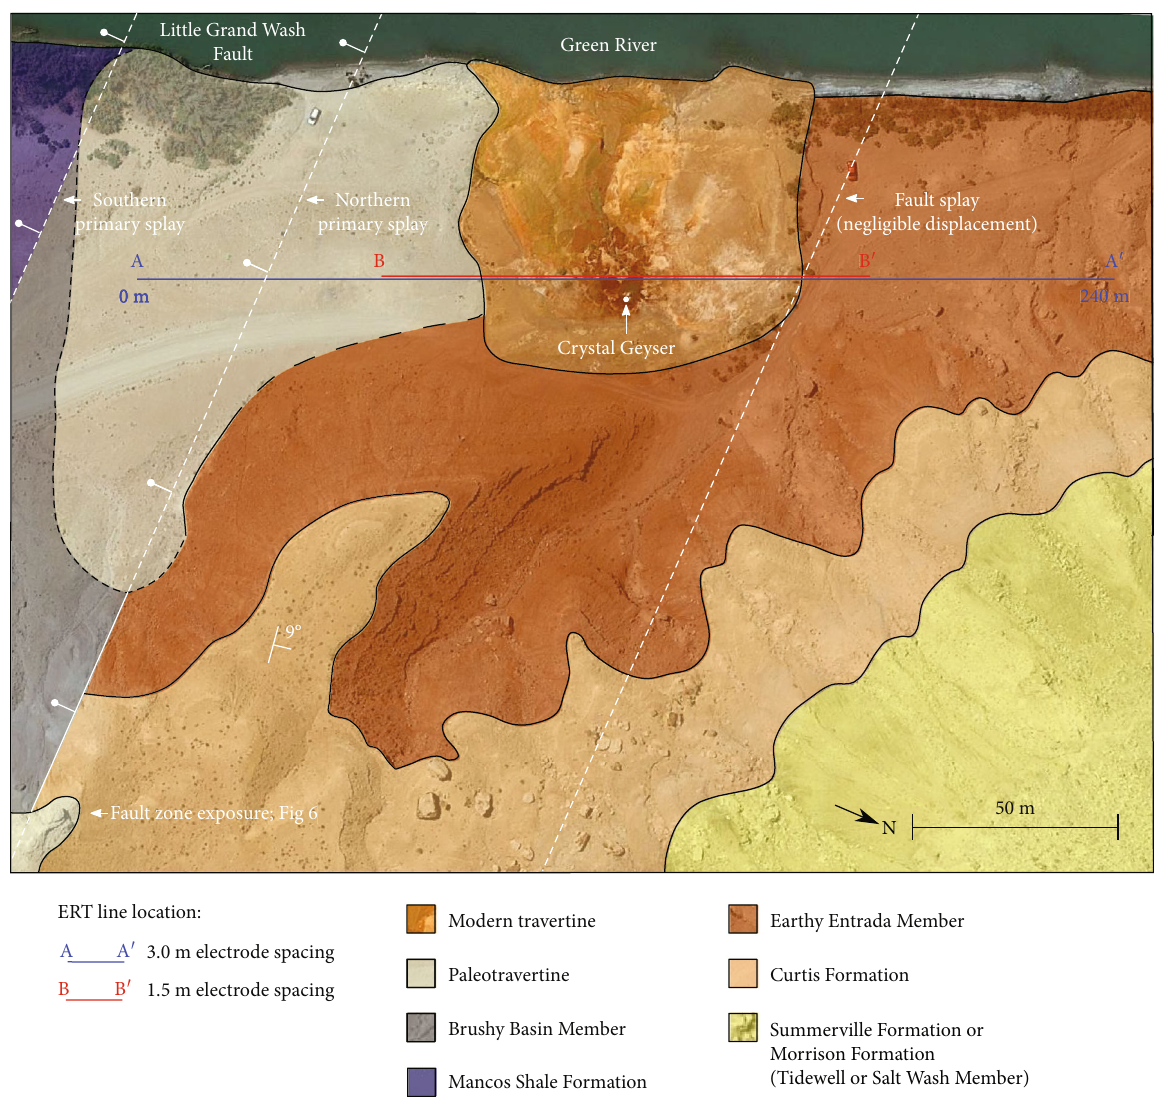
Figure 3: Site map of ERT survey lines with exposed geological units and fault traces (dashed white lines). The area is shown in the larger map of Figure 1(a). The lines overlie the northern primary splay of the Little Grand Wash Fault and another fault splay. Electrode spacings of 3.0 ( A ‐ A ′ ) and 1.5m ( B ‐ B ′ ) were used for surveys, resulting in total survey lengths of 240 and 120m, respectively. For all surveys, Crystal Geyser was located at the centre of the line, o ff set orthogonally by 5 m. The location of Figure 6 is indicated. The strike and dip measurement of the Curtis Formation is from Dockrill and Shipton [3]. Mapping of the stratigraphic units and travertines is from Shipton et al. [14] and Dockrill and Shipton [3], modi fi ed using the satellite image (Google Earth imagery date: August 24, 2019). The fault splay position was identi fi ed by Kampman et al.